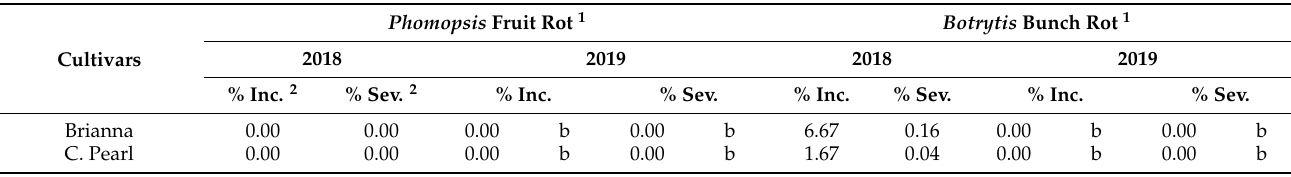
51.7% of the assessed ‘Marechal Foch’ fruit; for all other cultivars, less than 11.7% of the fruit was affected. Severity was greatest on ‘Marechal Foch’, with 1.6% of the surface affected, and a damaged cluster area below 1% for the remaining cultivars. Table 5. Comparison of the incidence percentage and severity of Phomopsis fruit rot and Botrytis bunch rot symptoms on grape fruit clusters in 2018 and